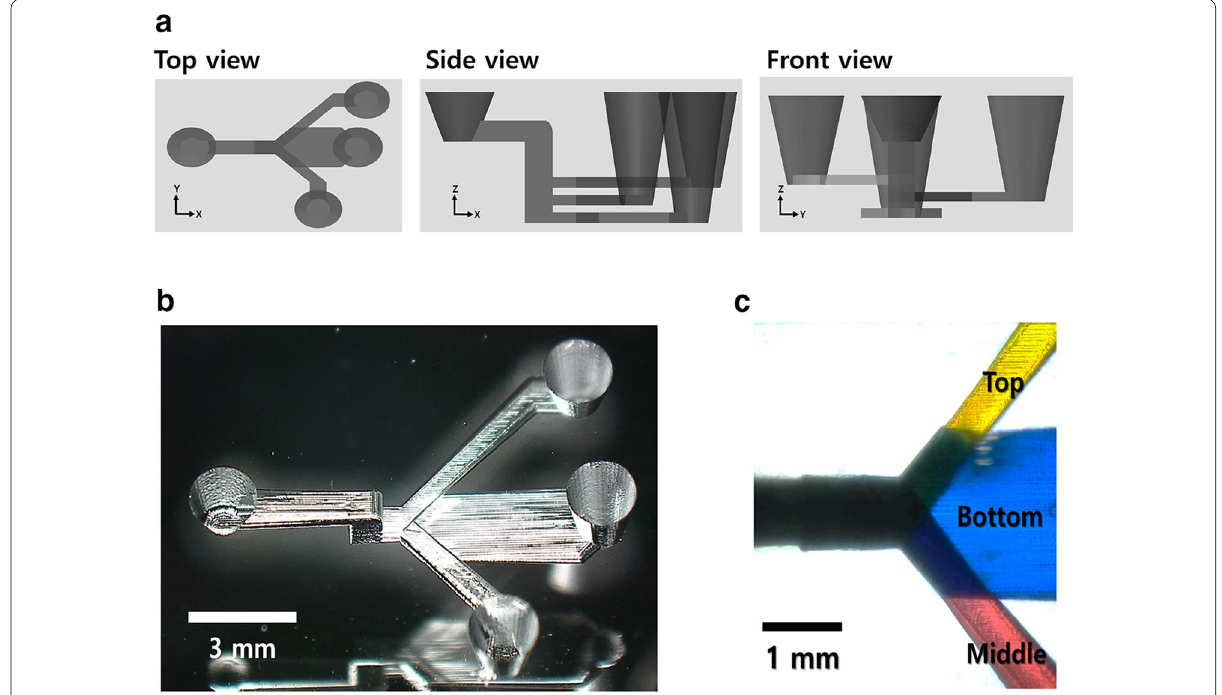
Fig. 5 a Converted STL structuring (slice and hatch) of a 3D microfluidic channel branching to three multilayered channels. b Fully etched multilayer microfluidic device in a glass substrate. c Picture of the fabricated multilayered microfluidic channels fully etched in 5